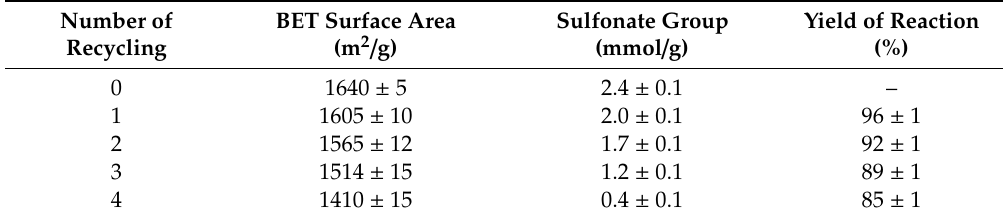
Table 5. E ff ects of number of reuse times of SAC-3 on specific surface area, sulfonate group and yield of reaction.